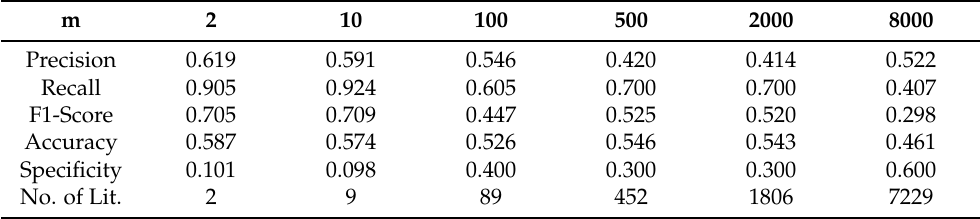
Table 18. Performance of TM with SSL continuous feature scheme on Liver Disorders